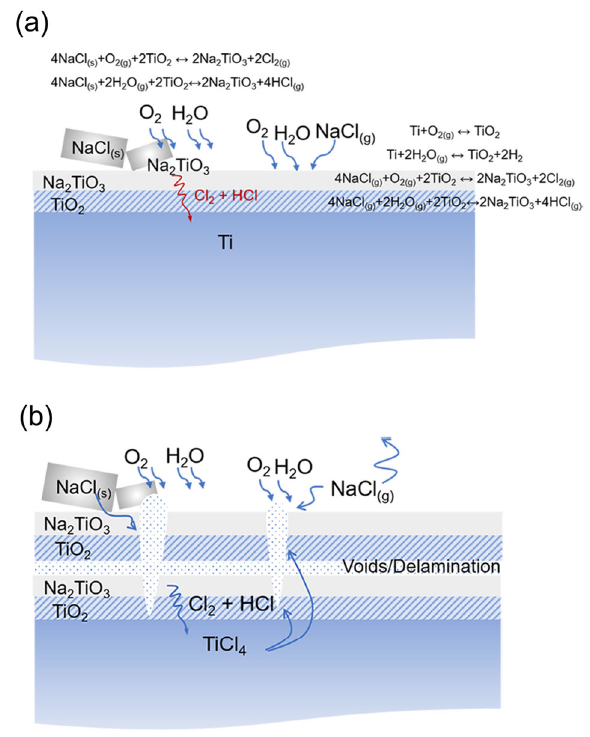
Fig. 10 Diagram of the corrosion mechanism of pure Ti in continuous NaCl solution spraying environment at 600 o C. a initial corrosion mechanism and b latter corrosion